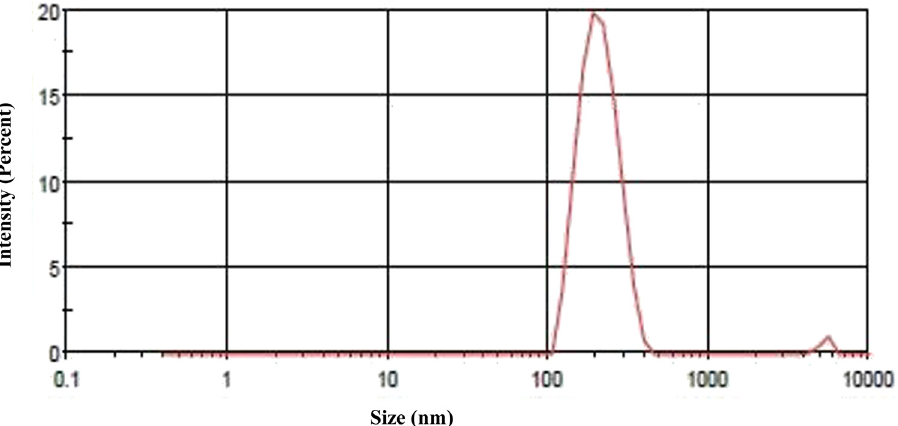
Figure 6: Particle size distribution of the fabricated Se NPs.